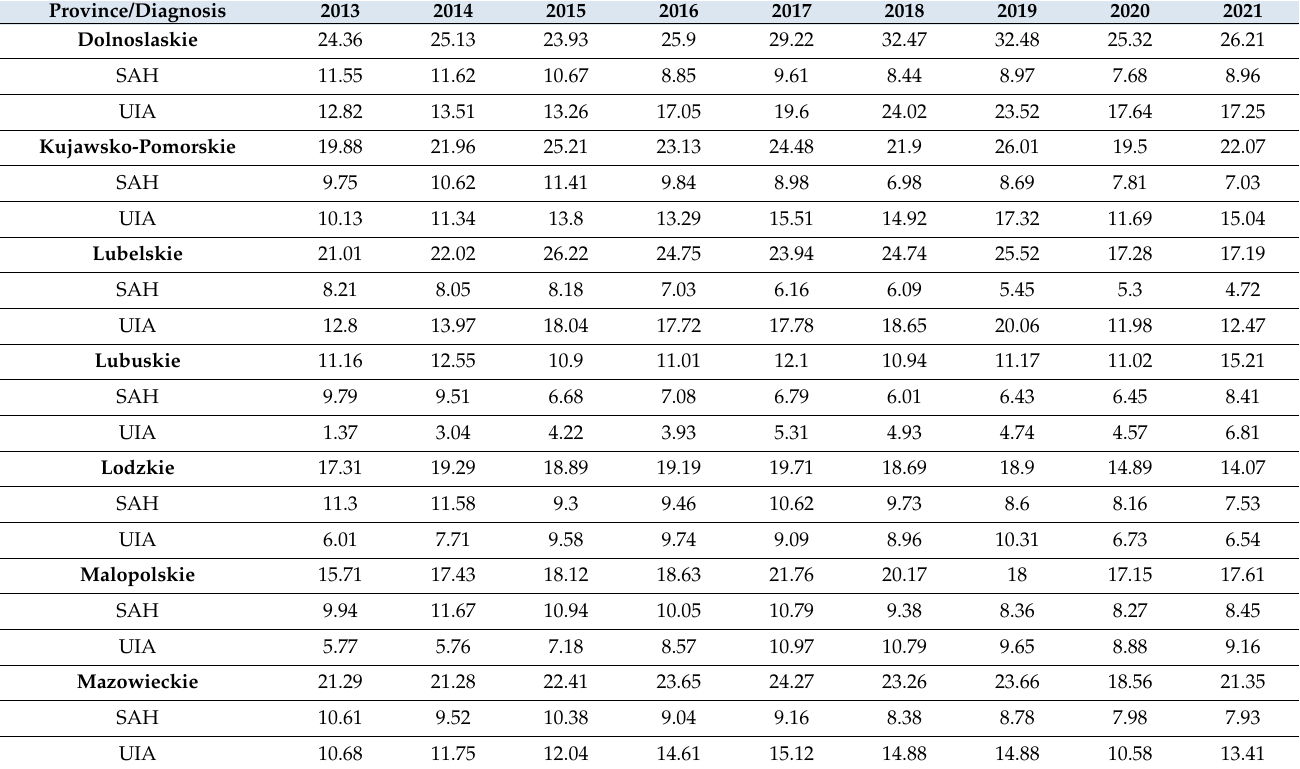
Table A1. The rate of patients with the type of the diagnosis reported by province per 100,000